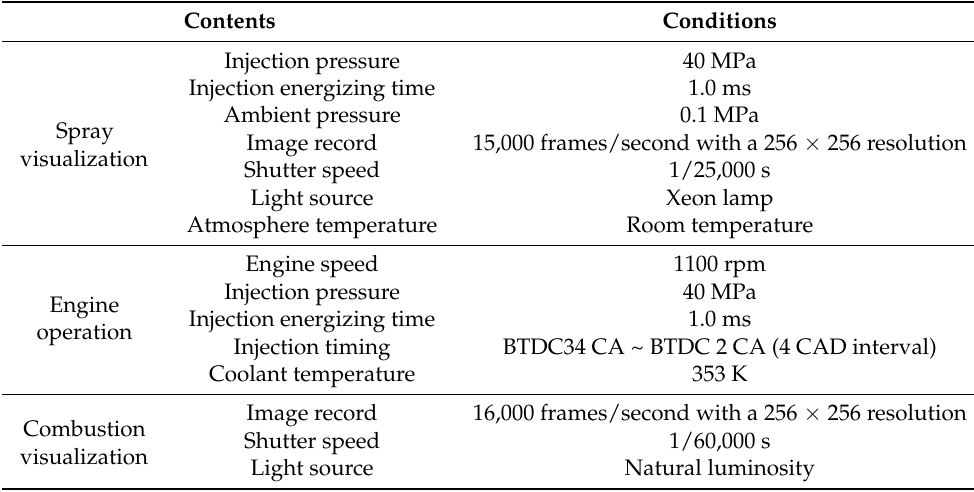
Table 3. Experimental